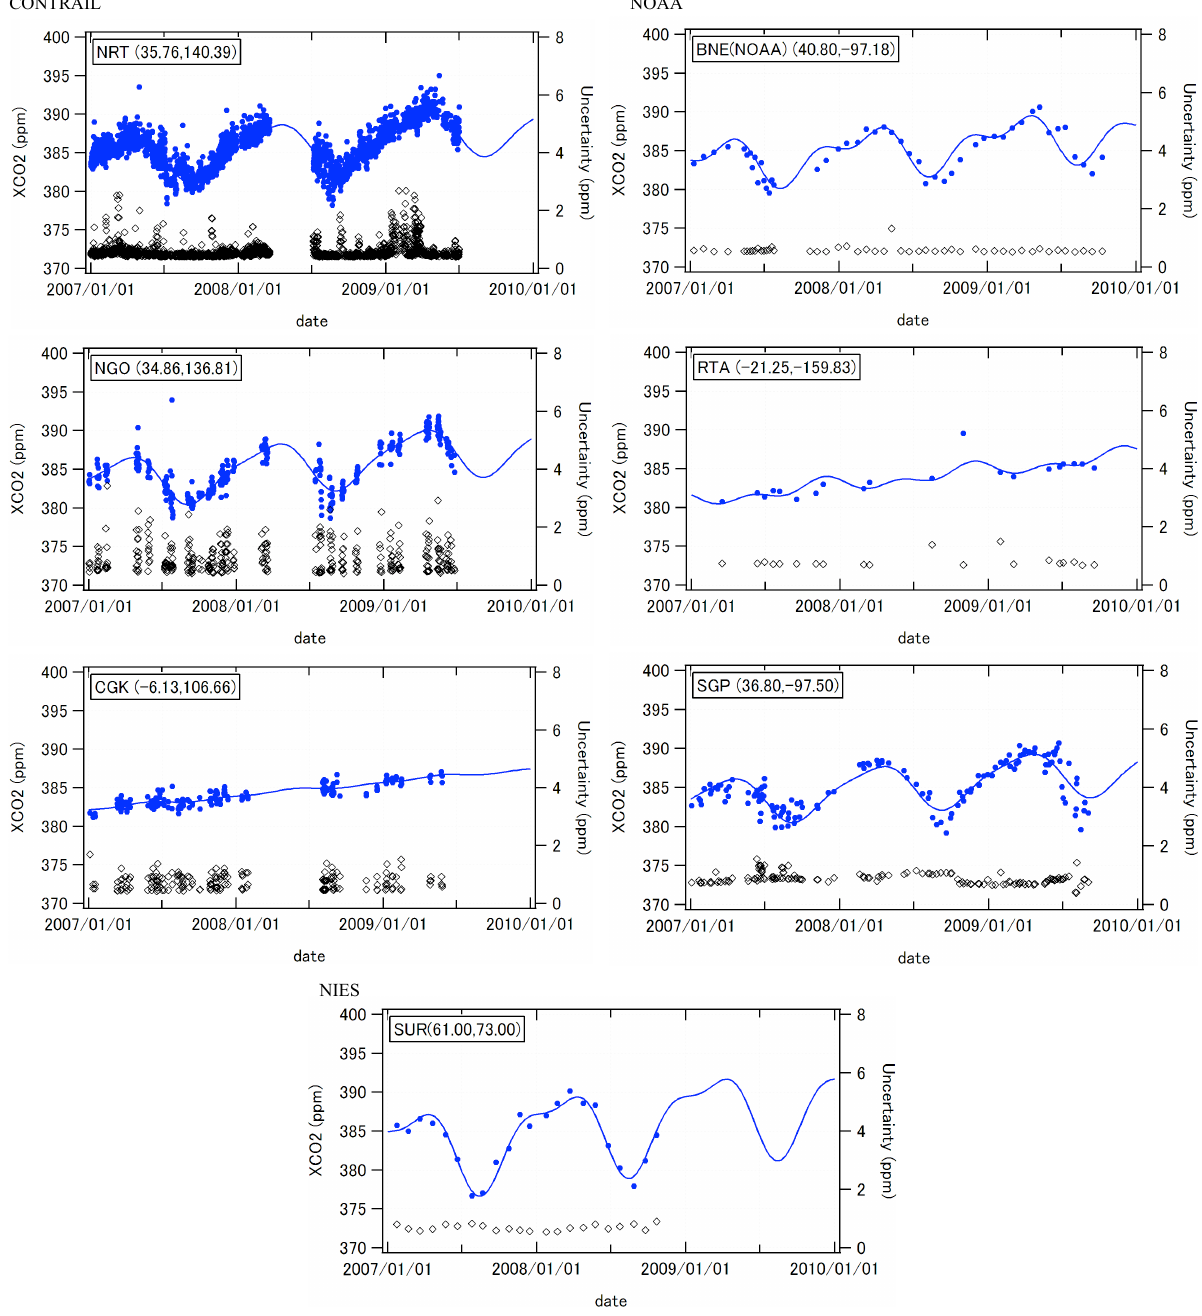
Fig. 4. Calculated XCO 2 values and their estimated uncertainties at NRT, NGO, CGK, BNE (NOAA), RTA, SGP and SUR. The site code (Table 1) and its latitude and longitude are shown at the upper left corner of each panel. Blue filled circles show XCO 2 (left axis), and black open rhomboids show their uncertainties (right axis). Blue solid lines show curves fitted to the temporal behavior of XCO 2 as a visual guide (only for sites where the number of data was sufficient).